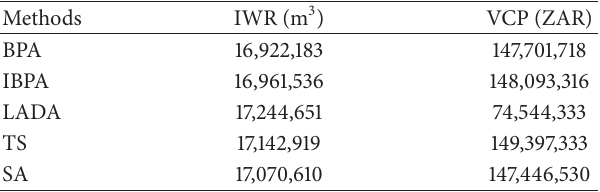
Figure 4: The performance of the heuristic algorithms in determin- ing their overall best fitness value solutions. Table 6: Statistics of the irrigation water requirements (IWR) and variable costs of production (VCP) for the best solutions found.